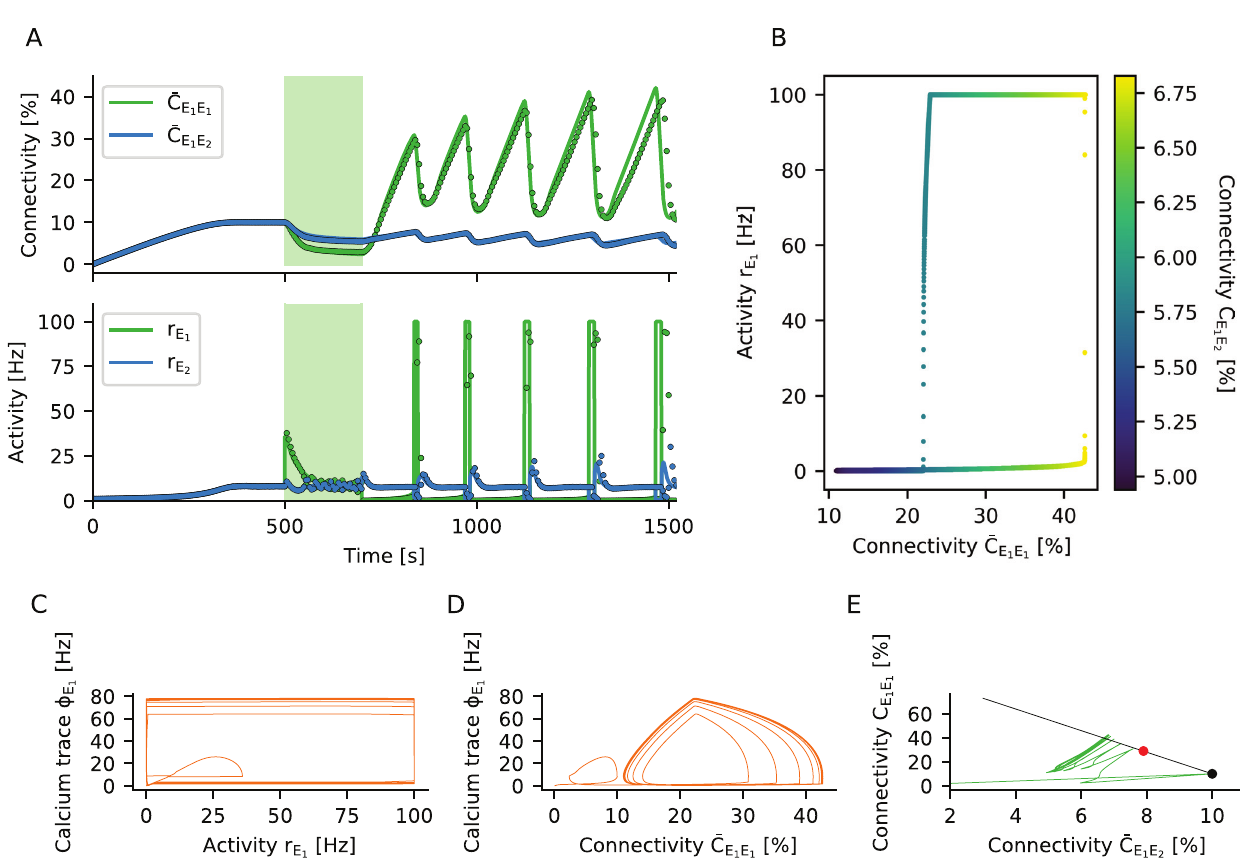
Fig 7. Non-linear stability of a network with homeostatic structural plasticity. (A) The engram E 1 is stimulated with a very strong external input. As the homeostatic response triggers excessive pruning of recurrent connections, the population E 1 is completely silenced after the stimulus is turned off. This, in turn, initiates a strong compensatory overshoot of connectivity and consecutive runaway population activity. The dots with corresponding color show the results of a plastic network simulation, and the solid lines indicate the corresponding predictions from our theory. The theoretical instantaneous firing rate is clipped at 100 Hz. (B) The network settles in a limit cycle of connectivity dynamics. The hysteresis-like behavior is caused by the faster growth of within- engram connectivity � C as compared to connectivity from the non-engram ensemble � C . During the initial phase of the cycle, the increase of � C has E 1 E 1 E 1 E 2 E 1 E 1 no effect on the activity of population E 1 yet, as its neurons are not active. Only when the input from population E 2 through � C gets large enough, the rate E 1 E 2 becomes non-zero and rises to very high values quickly due to already large recurrent � C connectivity. (C) The calcium signal ϕ adds an additional r E 1 E 1 E 1 delay to the cycle. (D) This leads to smoother trajectories when scattering calcium concentration against connectivity. (E) Connectivity within the